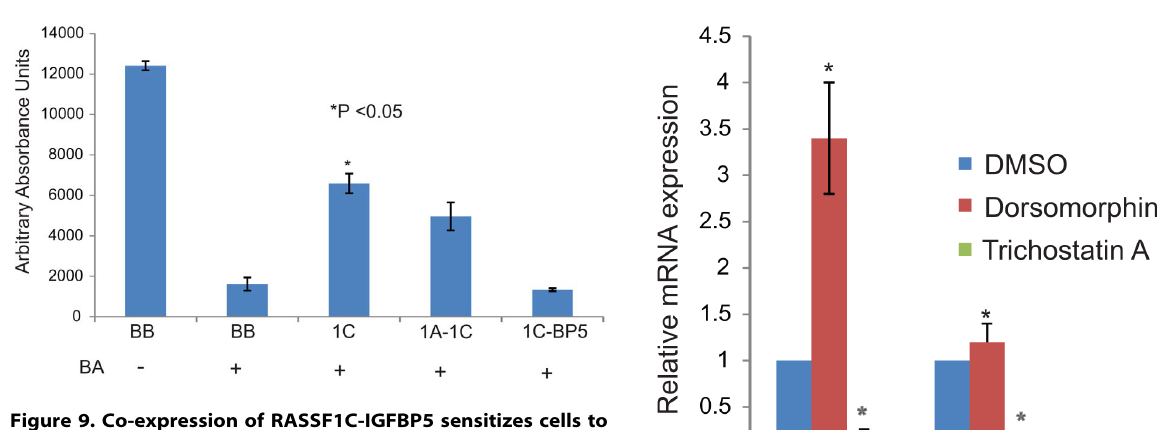
Figure 9. Co-expression of RASSF1C-IGFBP5 sensitizes cells to betulinic acid . H1299-BB, H1299-1C, H1299-1A-1C, and H1299-1C-BP5 cells were treated with betulinic acid (BA) for 24 h. Cells were then assayed for cell viability/proliferation. Cells co-expressing RASSF1C- IGFBP-5 were more sensitive to BA compared to cells over-expressing RASSF1C or co-expressing RASSF1A-RASSF1C. Data is representative of at least 3 independent experiments, and the values represent the mean 6 SEM. * P , 0.05: for 1C compared to BB.